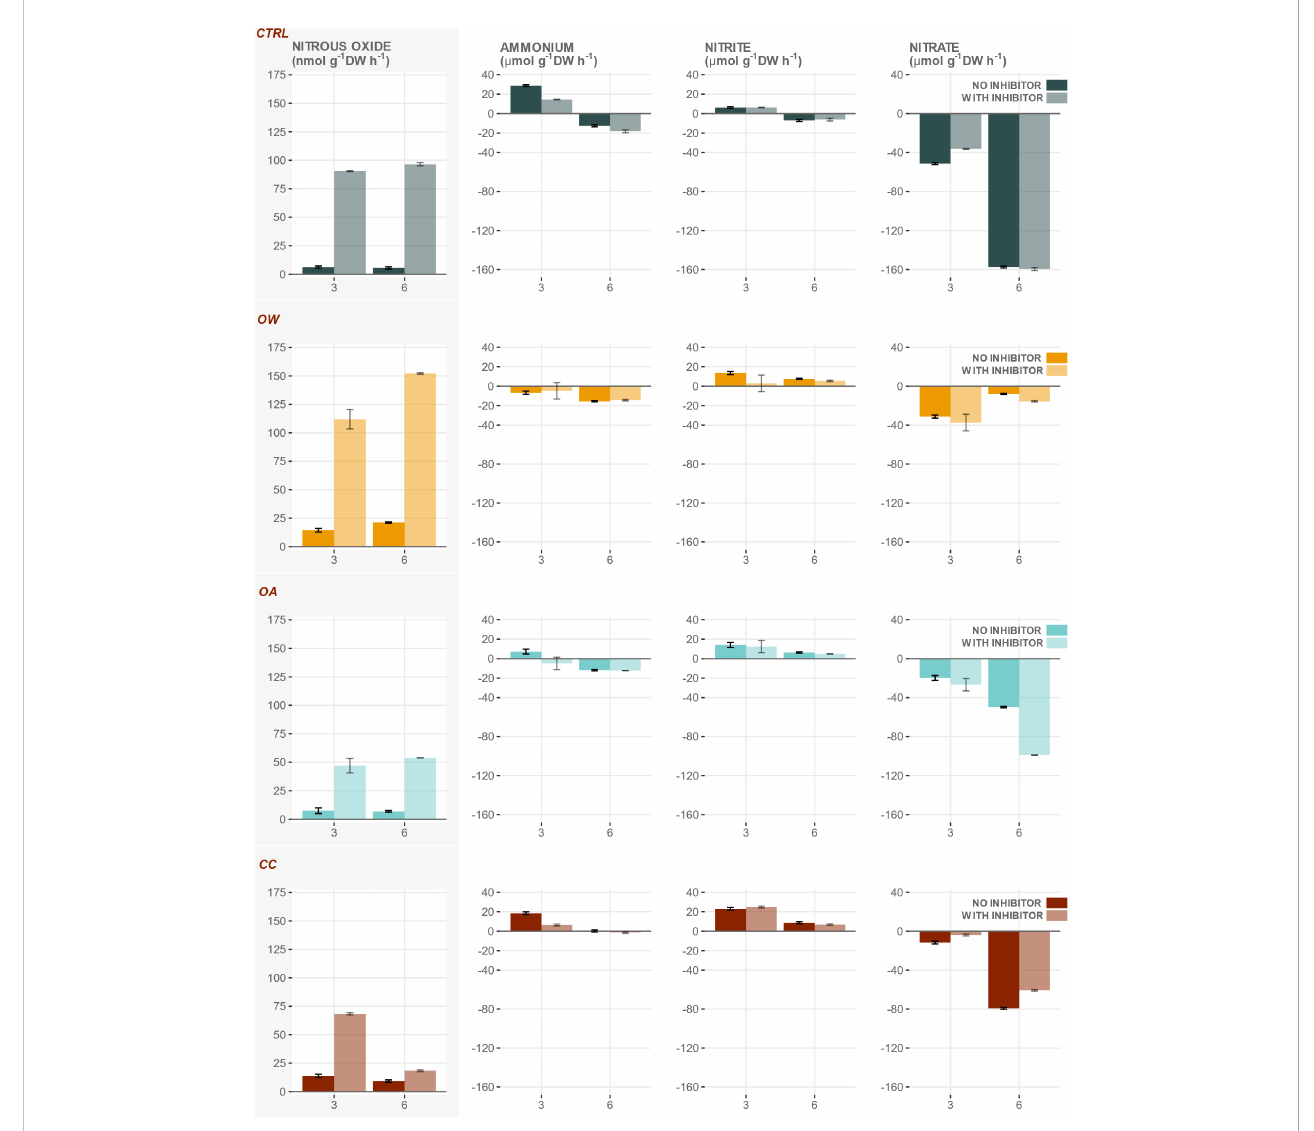
TABLE 5 R 2 of fi nal linear regression models with signi fi cance of Temperature (TEMP), pH (PH), two-way interaction (TEMP x PH) and week (WEEK) in incubations with and without inhibitor NaClO 3 for production of N 2 O [nmol g -1 DW h -1 ]. R 2 temp pH TEMPxPH WEEK